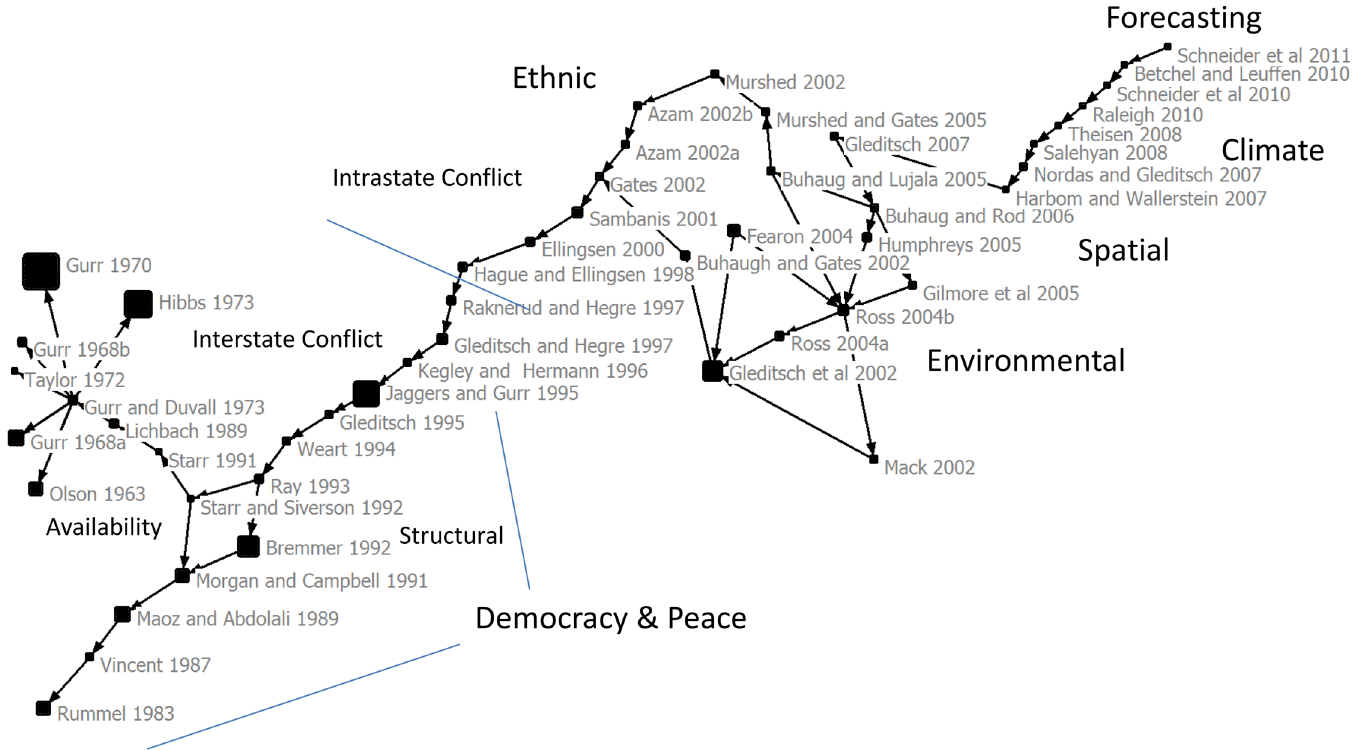
Fig 1. Critical path and scientific influence in conflict science. The critical path shows that conflict research was a coherent field of inquiry that built on the work of previous scholars. Earlier articles focused on the role of democracy in interstate conflict. They explained the need for relevant indicators, introduced key datasets that helped the discipline develop, and showed structural level analyses. The origins of availability theory, whether resource scarcity affects conflict, was the first node. Later articles focused on interstate conflict, which introduced ethic and environmental conflict research. Spatial analyses and forecasting built upon earlier indicators and theories to get finer resolution datasets and sophisticates analyses, which showed that the discipline was well developed. Node size was proportional to total citations as of